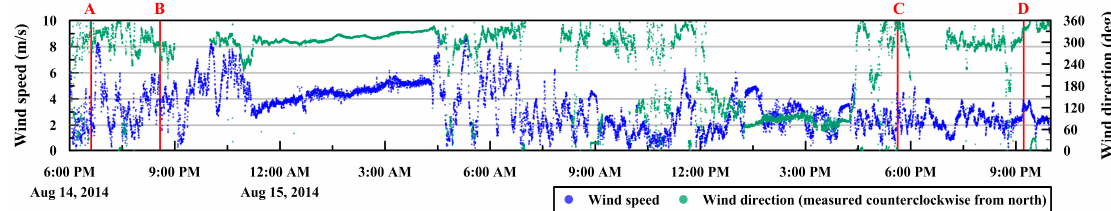
Figure 7. Wind speed and direction, of which the wind originates, measured in the IBRV Araon during the image acquisition period, refined by 10 s moving average. The A, B, C and D denote the image acquisition times.